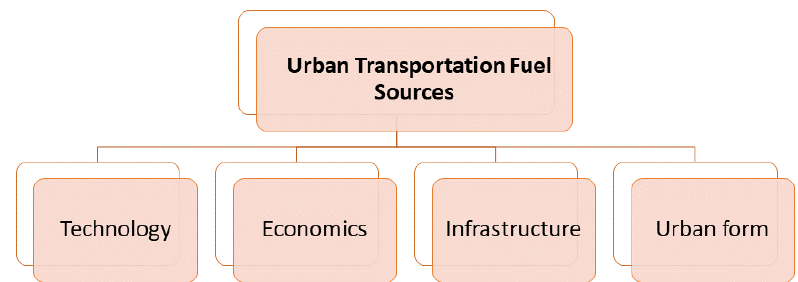
Figure 3. Decisive factors in the type of urban transportation fuel sources.